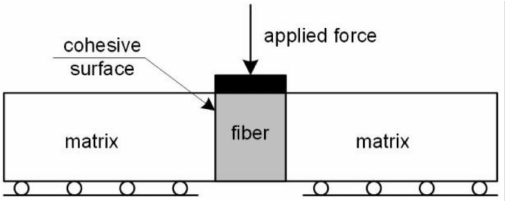
Figure 8. Push-out test of titanium matrix composite reinforced by silicon carbide (SCS-6) fiber